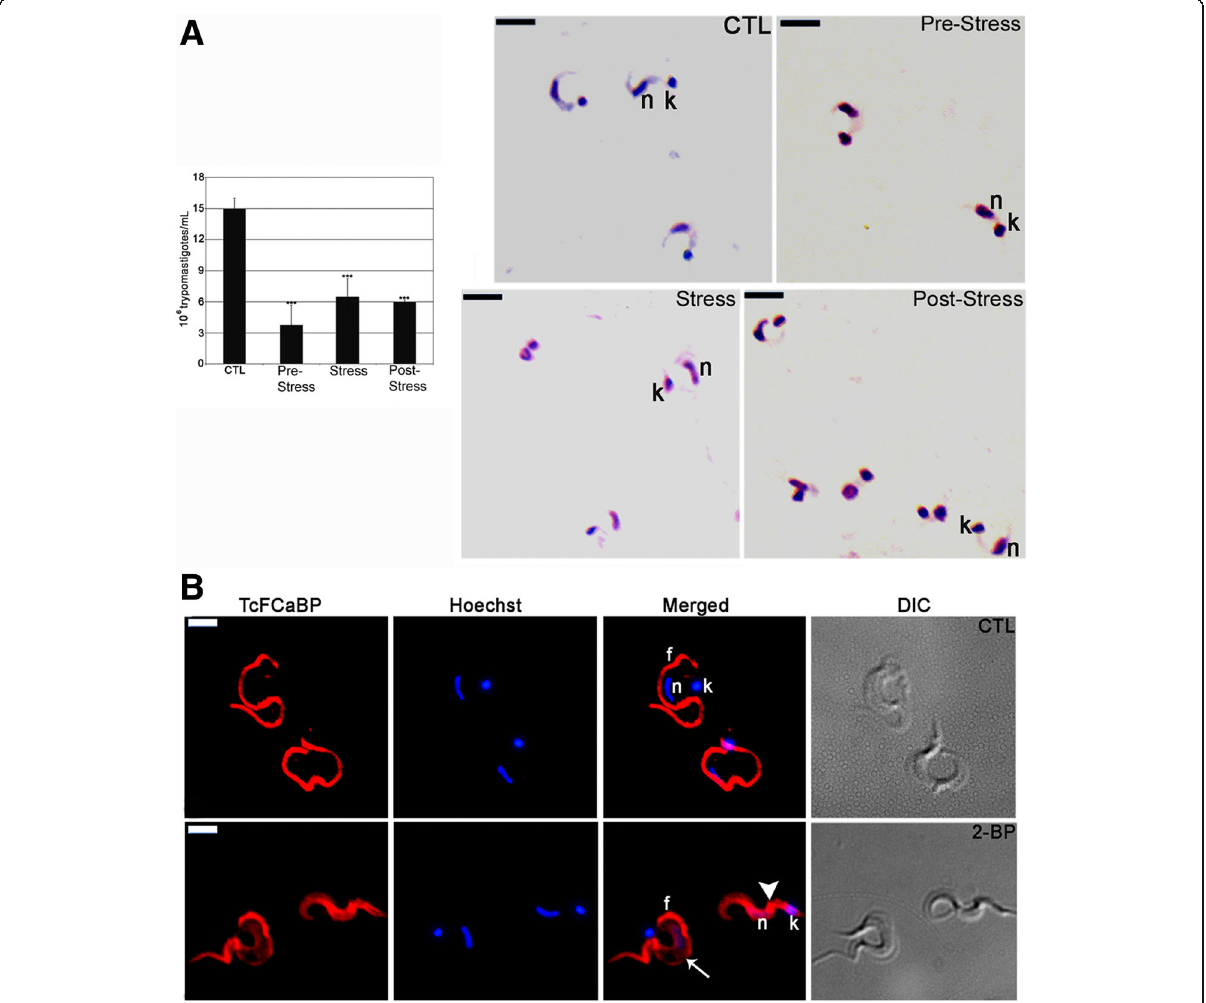
Fig. 8 2-BP treatment during metacyclogenesis alters Trypanosoma cruzi host cell infectivity. a Number of released cell-culture trypomastigotes (CTL and 2-BP-treated groups) after Vero cell infection, showing a reduction of approximately 45.5% to 75% for the treated groups when compared to the control parasites. n = 3, ***: p < 0.001. Released cell-culture trypomastigotes (CTL and 2-BP-treated groups) as visualized by light microscopy showing morphological alterations, such as smaller size and round nucleus, compared to the control parasites. n: nucleus; k: kinetoplast. Bars = 5 μ m. b Localization of TcFCaBP of Trypanosoma cruzi trypomastigotes released from Vero cells infected with 2-BP-treated metacyclic trypomastigotes (pre-stress group). CTL: Negative control showing a strong labeling in the flagellum. 2-BP: Treated parasites showing cellular (arrowhead) and partial flagellar (arrow) labeling. n: nucleus; k: kinetoplast; f: flagellum. Bars = 5 μ